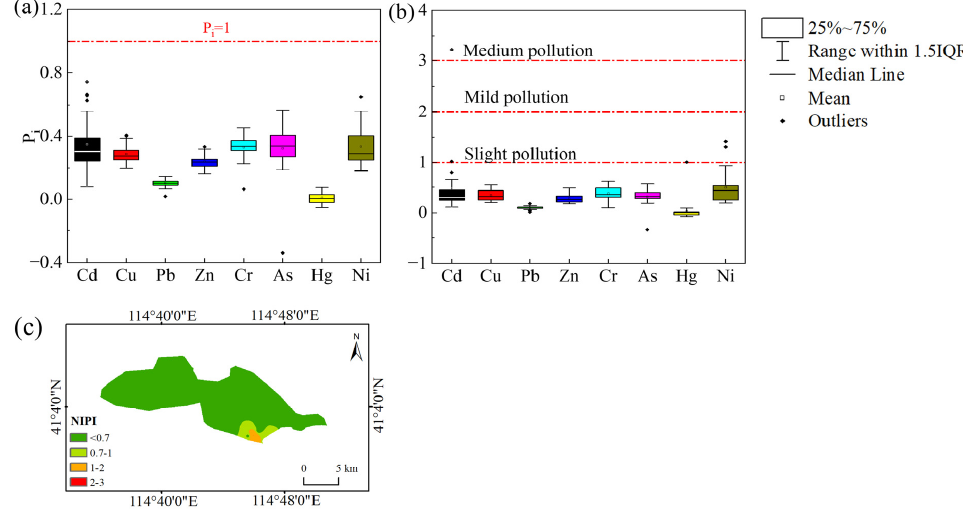
Figure 3. P i of heavy metals in soil planted with potato ( a ) and hulless oats ( b ), respectively; NIPI of heavy metals in soil planted with hulless oats ( c ).